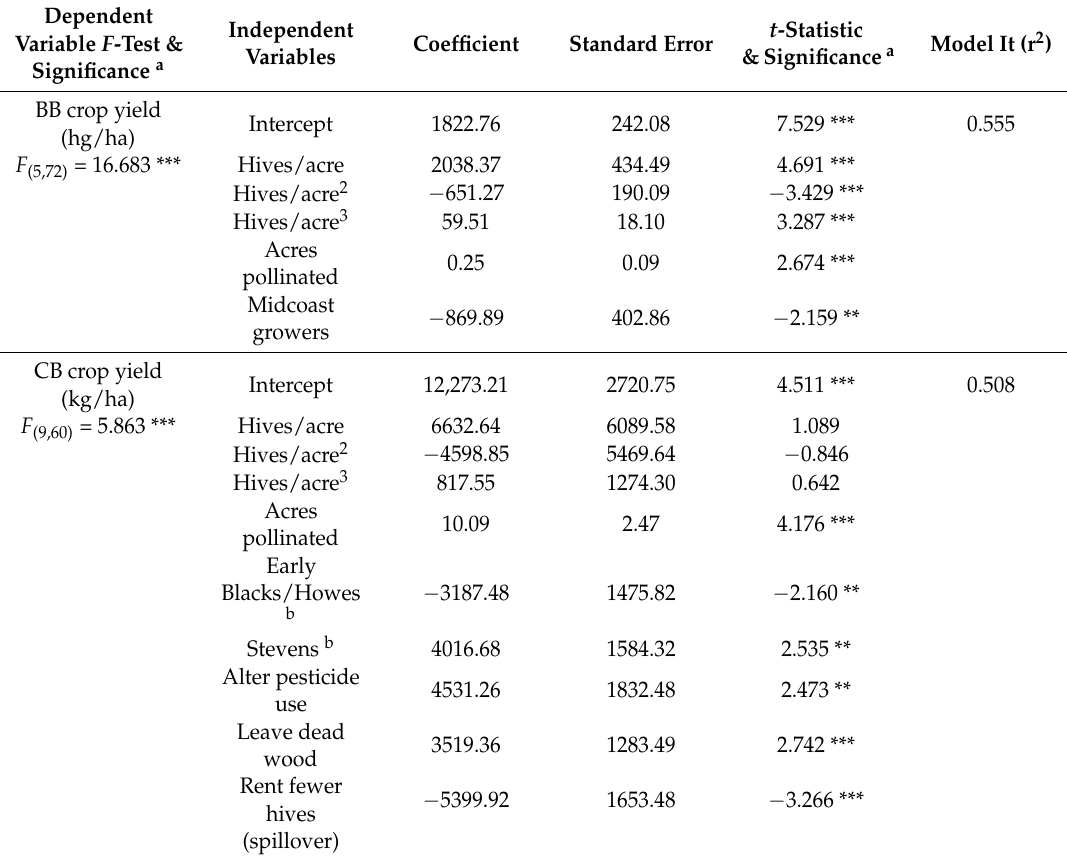
Linear multivariate regression estimates for Maine, USA, wild blueberry (BB) and Massachusetts, USA, cranberry (CB) production